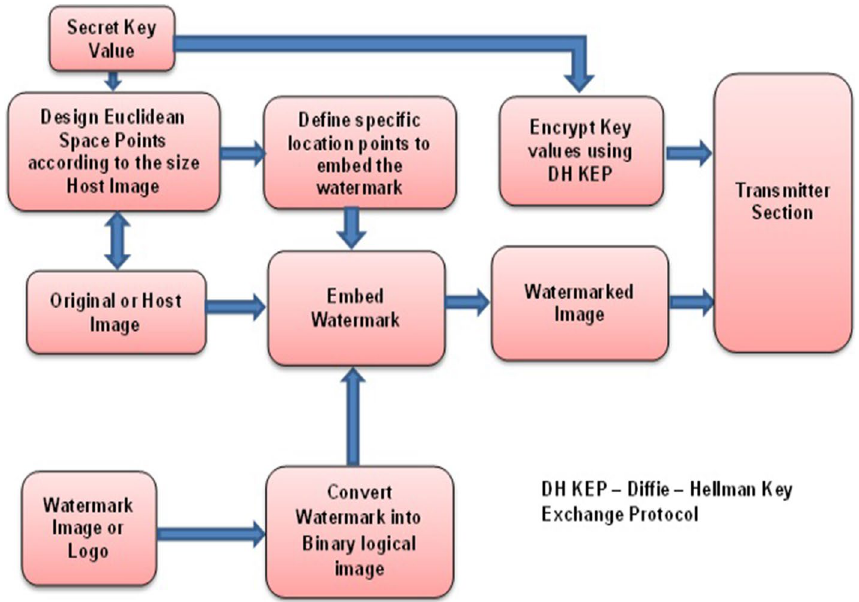
Fig. 1 Euclidean space points spatial domain